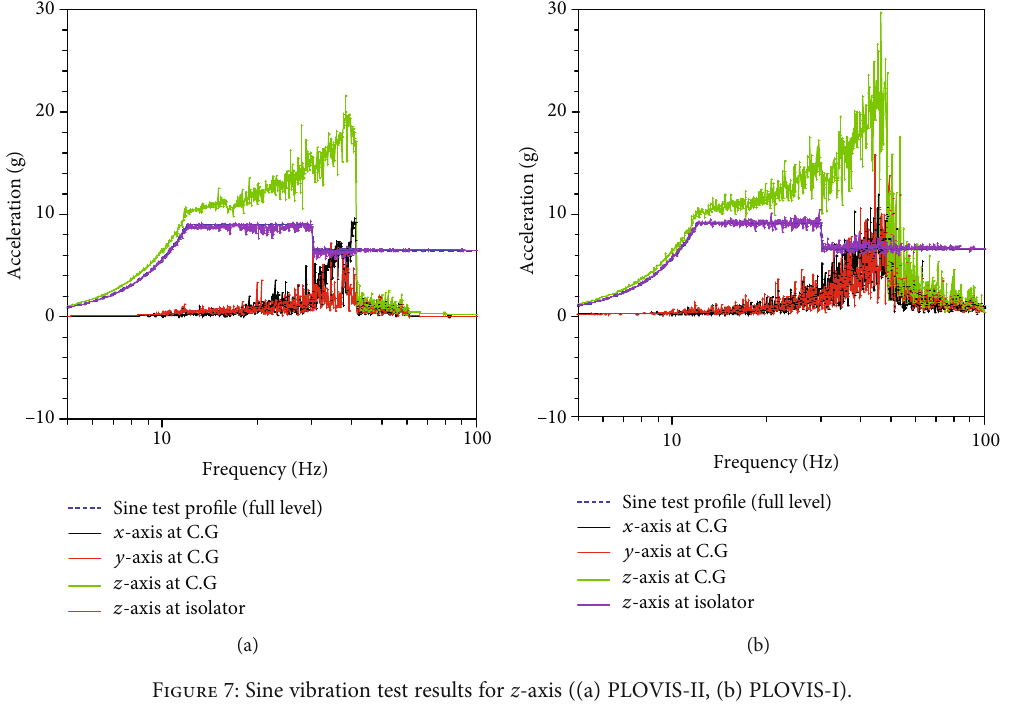
Figure 7: Sine vibration test results for z -axis ((a) PLOVIS-II, (b) PLOVIS-I).